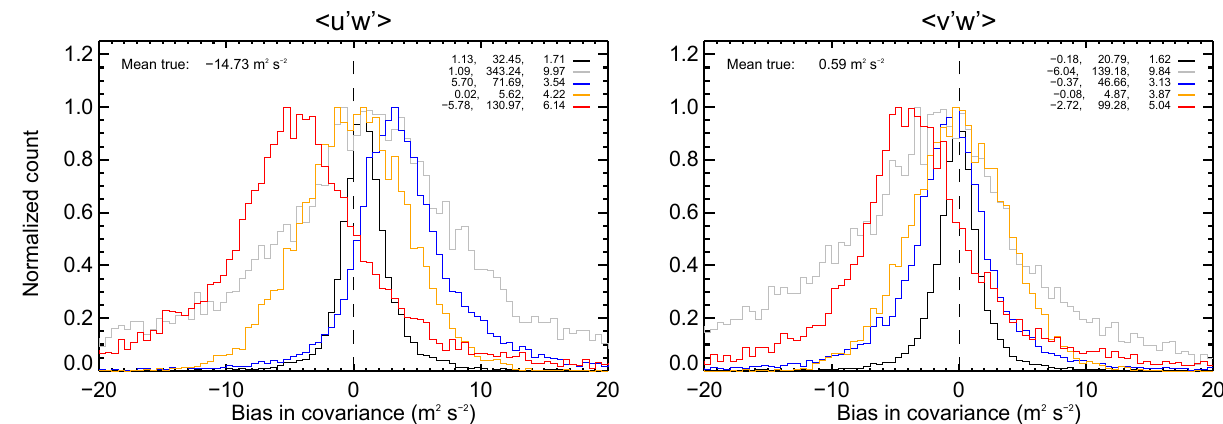
Figure 9. Normalized histograms showing the biases in the wind field covariance components, evaluated using the 5BD (black), V5BD (grey), VBD (blue), meteor (orange), and C5BD (red) techniques. The biases’ mean, standard deviation, and standard deviation evaluated from the samples’ median absolute deviation (see text for details) are also indicated in sequential order in three-element arrays for each technique in the upper-right corner of the